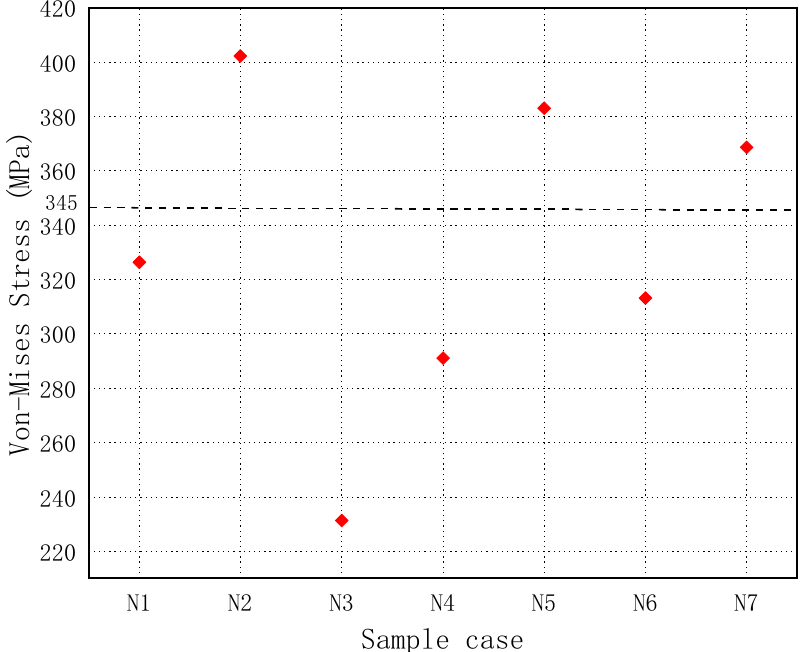
(cid:3) : a front impact; : a tail impact. (cid:35)